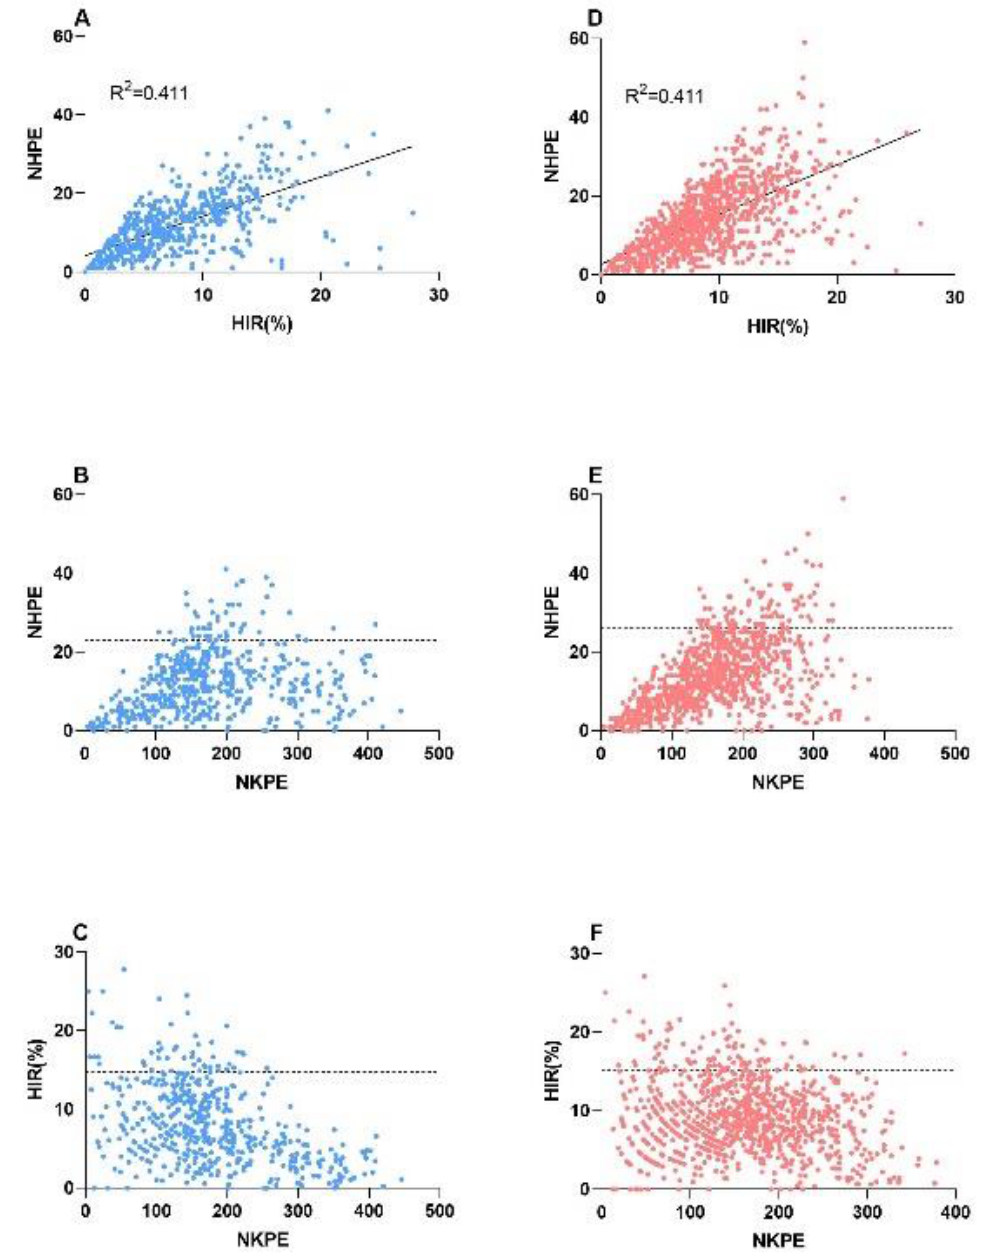
Figure 3. Analysis of the relationships between the NHPE, HIR, and NKPE. ( A ), ( B ) and ( C ) correspond to the population of CAU3; ( D ), ( E ) and ( F ) correspond to the population of CAU5. The solid lines in ( A ) and ( D ) indicate the trend of the correlation analysis. The dotted lines on ( B ), ( C ), ( E ) and ( F ) represent the threshold of the top 10% of the NHPE/HIR.